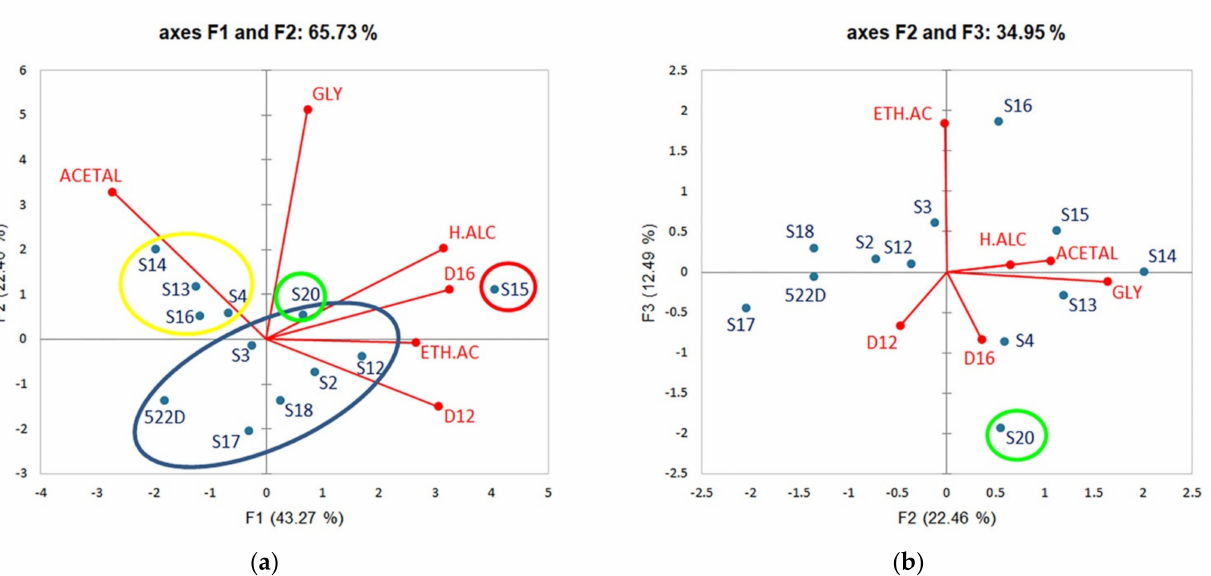
Figure 5. Principal component analysis (PCA) plots based on oenological parameters determined for 11 indigenous S. cerevisiae strains and 522D and their experimental wines. ( a ) Biplot of axis F1 and F2 explaining 65.73% of the variation. ( b ) Biplot of axis F2 and F3 explaining 34.95% of the variation. Variables: oenological parameters Observations: strains. ACETAL: Acetaldehyde; GLY: Glycerol; H.ALC: Higher Alcohols; ETH.A: Ethyl acetate; D12 and D16: resistance to 12 and 16% ethanol. Strains circled in yellow were excluded, while the ones circled in blue, green and red were retained for further analysis (for details, check the text